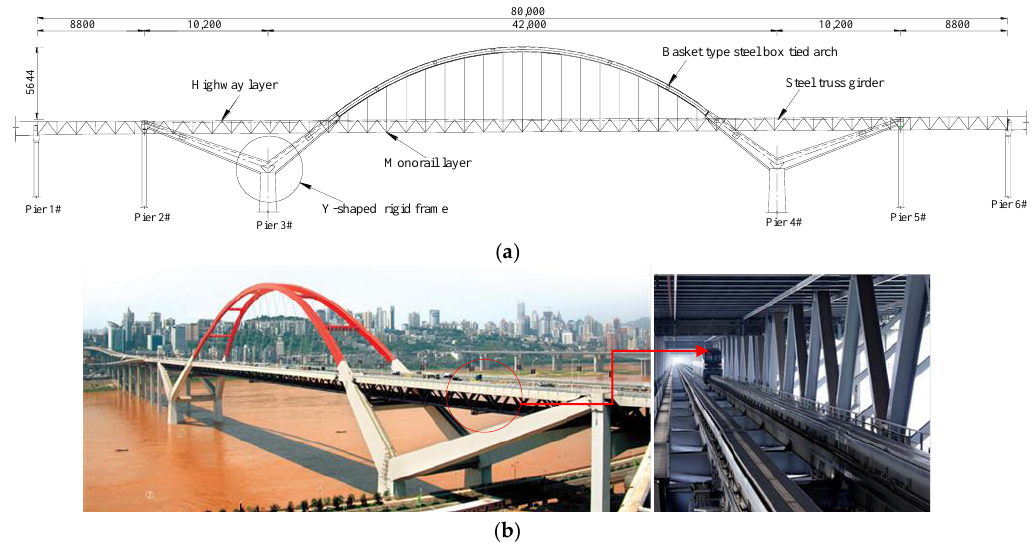
Figure 1. The layout of the Caiyuanba Yangtze Bridge (unit: cm): ( a ) elevation view; ( b ) overview. The main arch ribs produce the horizontal thrust both inside and outside the plane under the dead load and operating live load. The steel truss girder is a truss structure with an orthotropic bridge deck, bearing the vertical operating load as well as the large horizontal thrust. The horizontal thrust of the arch is supported by the steel beam of the ribs and the rigid frame concrete beam.